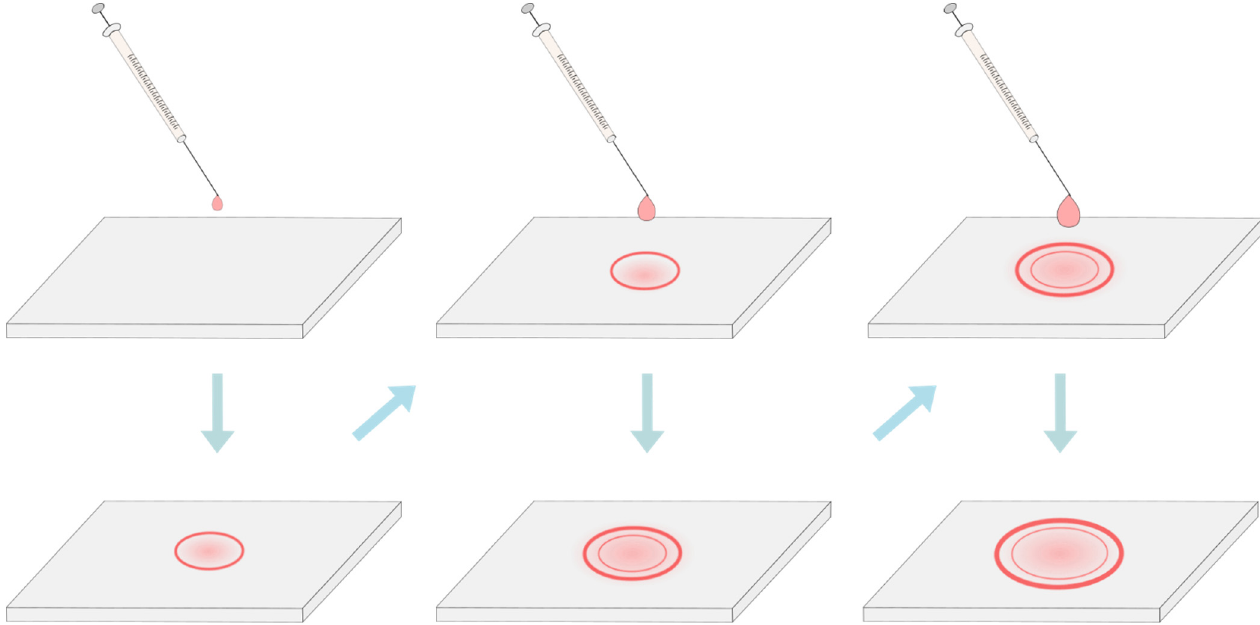
Figure 4. Deposition of lipids utilizing the coffee ring effect. After drying, most of the material is carried away toward the periphery and a ring-like stain is formed. This is known as the coffee-ring effect. By depositing progressively larger droplets, the ring from the previous droplets gets smeared and flattened, thus leaving behind an area of uniform lipid film thickness.